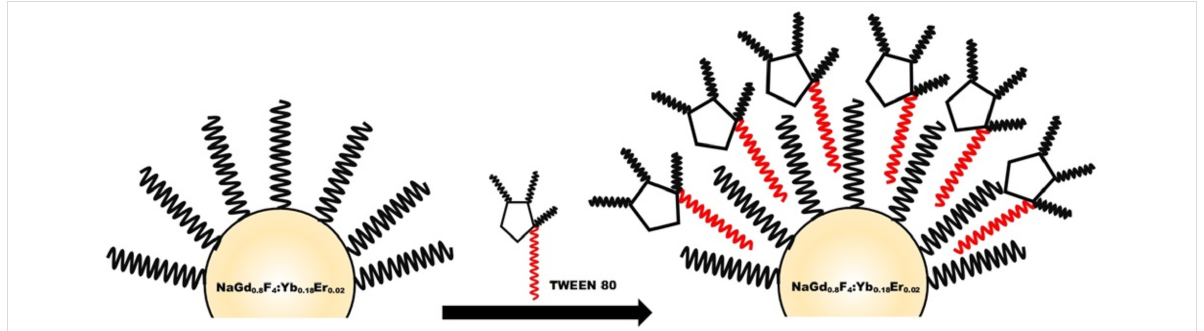
Figure 7: Formation of water-soluble core and core–shell UCNPs by coating with Tween 80.